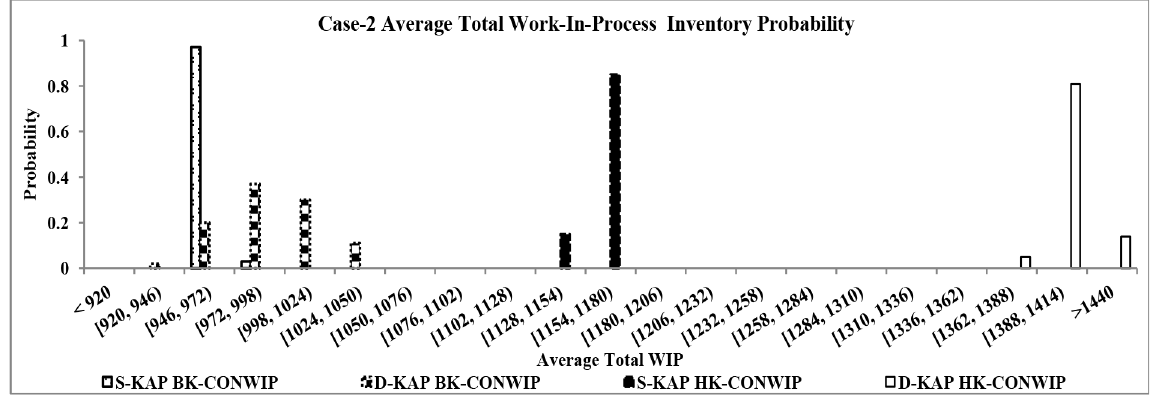
Figure 10. Case-2 average total WIP probability histogram